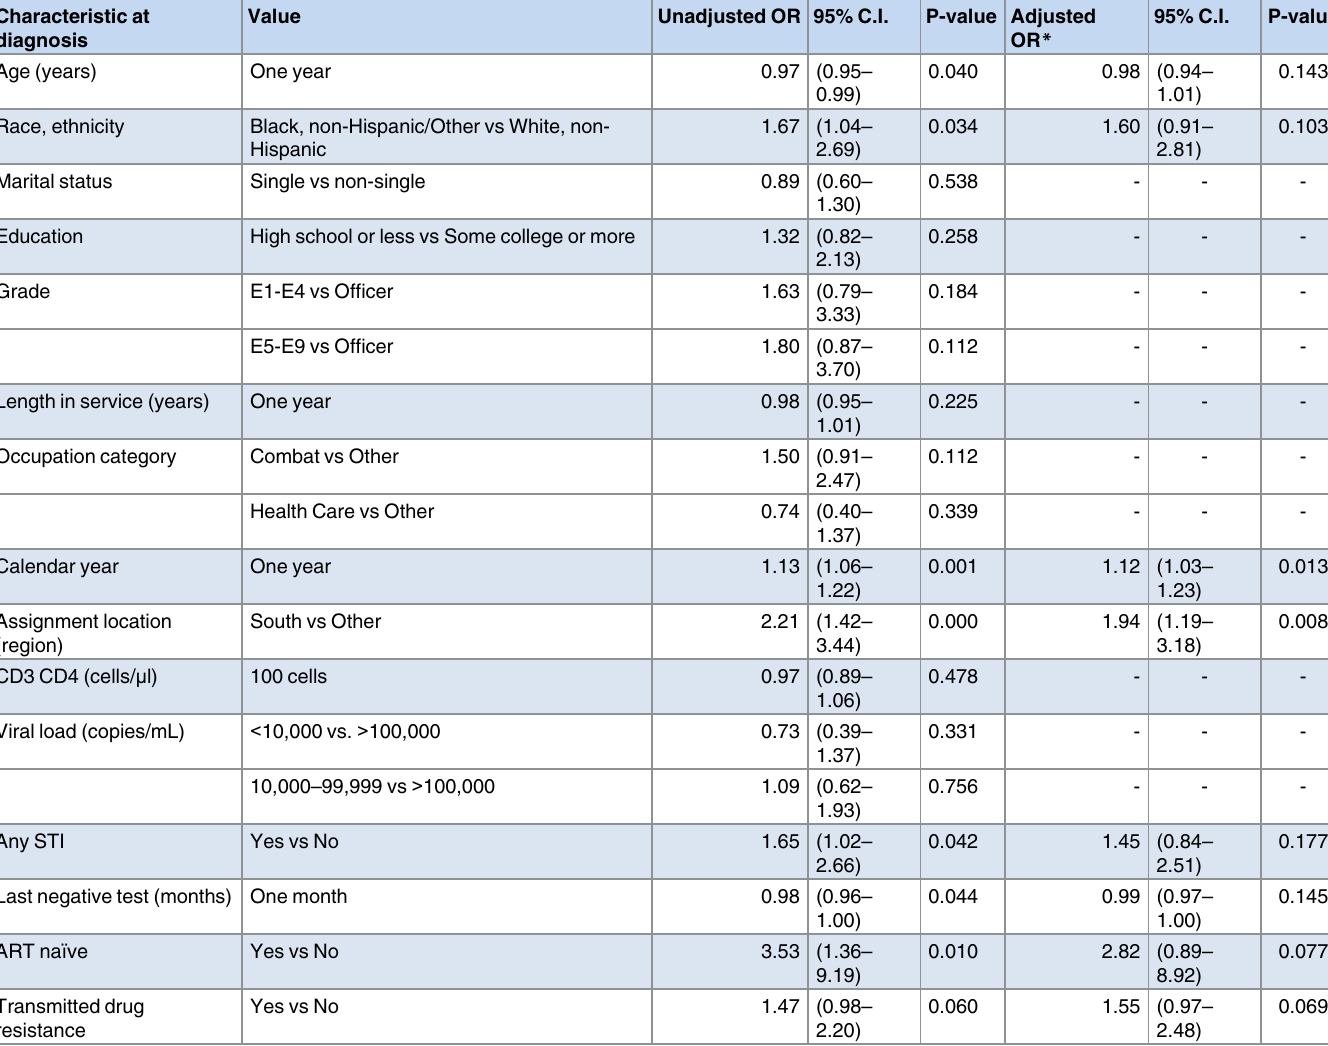
Table 2. Characteristics of 518 newly diagnosed HIV-infected Soldiers associatedwith transmission clustering,